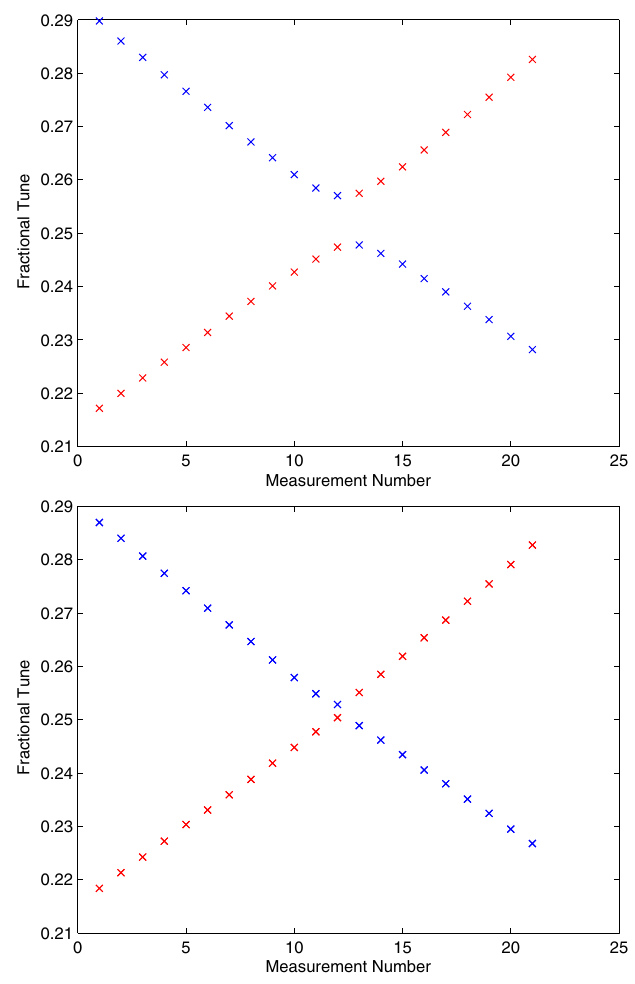
FIG. 7. Tune measurements of horizontal (blue) and vertical (red) tunes as they are brought to resonance. The upper plot shows the 0.9% coupling measurement and the lower plot shows the 0.07%